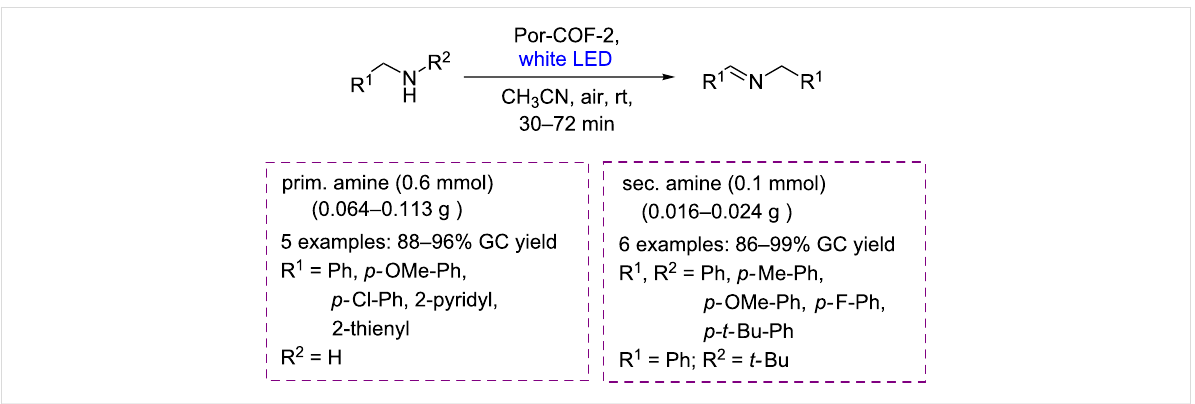
high yield and selectivity, and the Ugi products were obtained after removal of the solvent and direct addition of isocyanide and carboxylic acid. The Ugi products were obtained